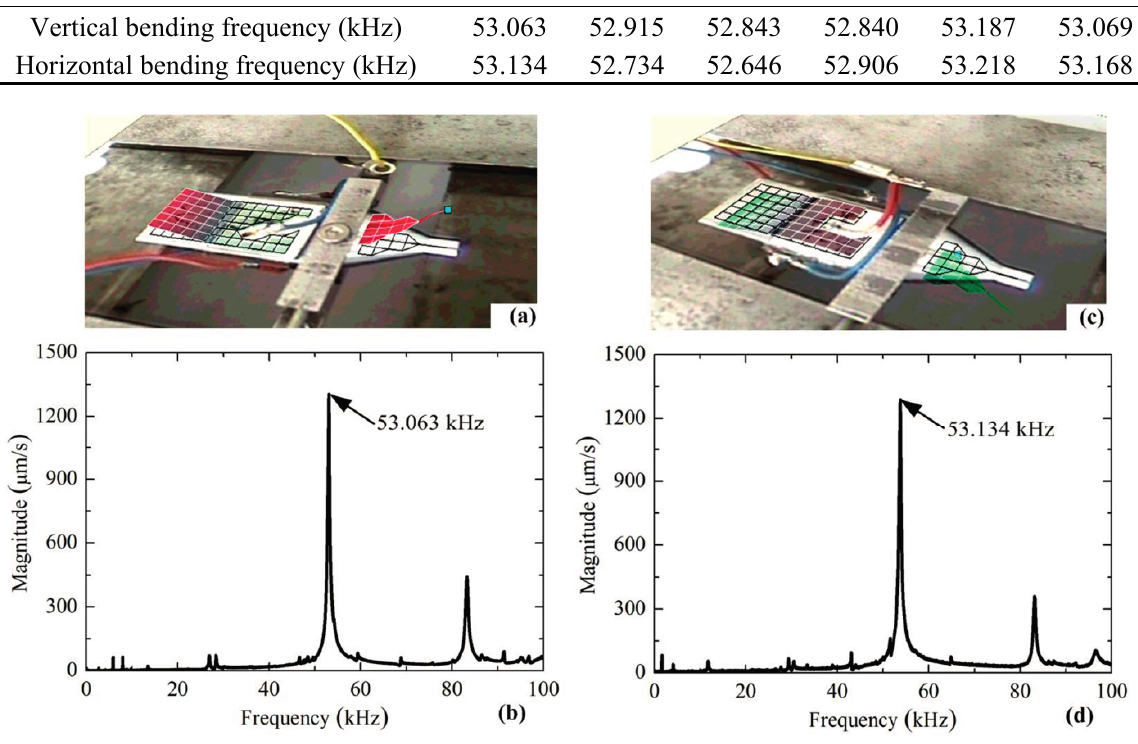
Figure 8. Vibration measurement result of transducer-1: ( a ) vibration shape of vertical bending; ( b ) vibration velocity response spectrum of vertical bending; ( c ) vibration shape of horizontal bending; ( d ) vibration velocity response spectrum of horizontal